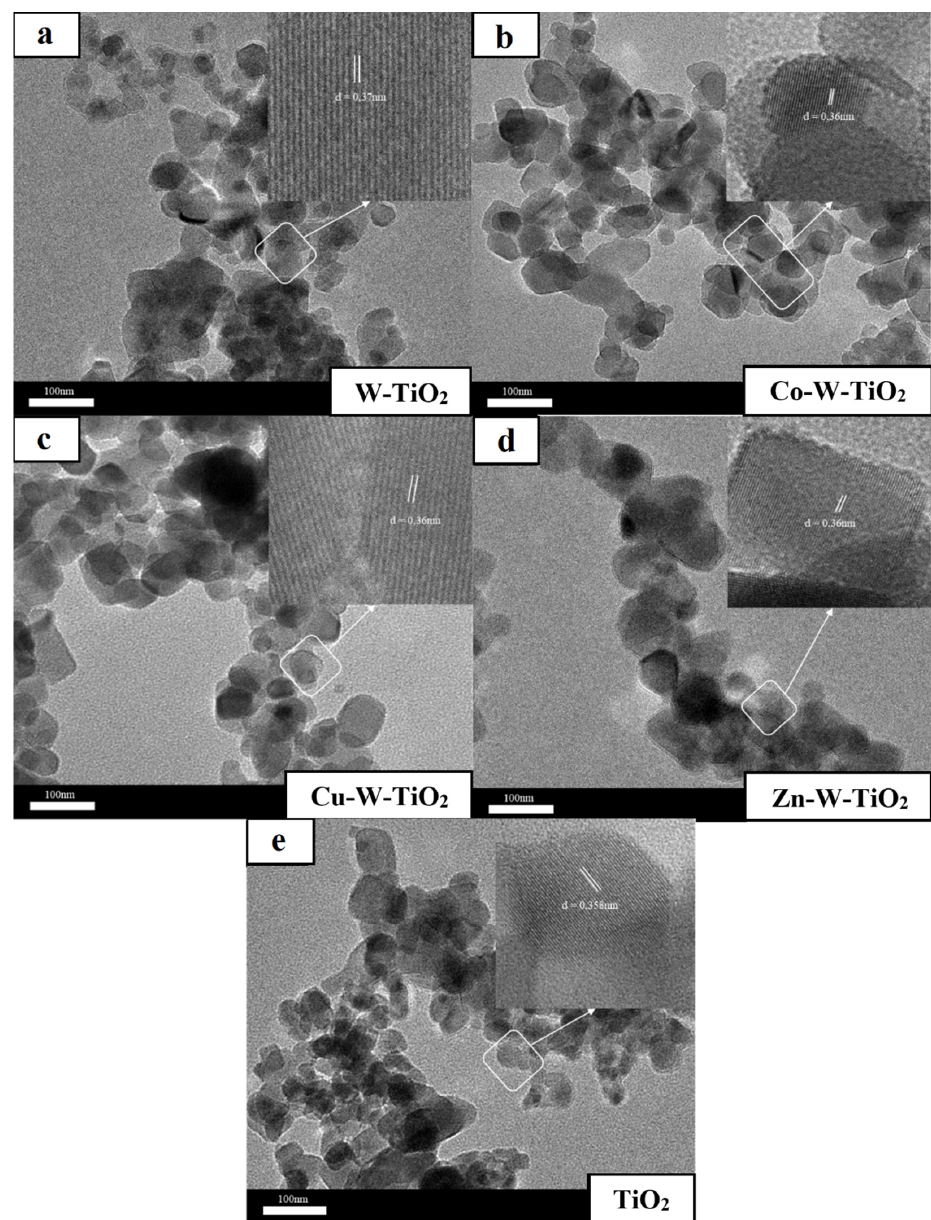
Figure 9. TEM analysis of ( a ) W ‐ TiO 2 , ( b ) Co ‐ W ‐ TiO 2 , ( c ) Cu ‐ W ‐ TiO 2 , ( d ) Zn ‐ W ‐ TiO 2 , and ( e ) TiO 2 .